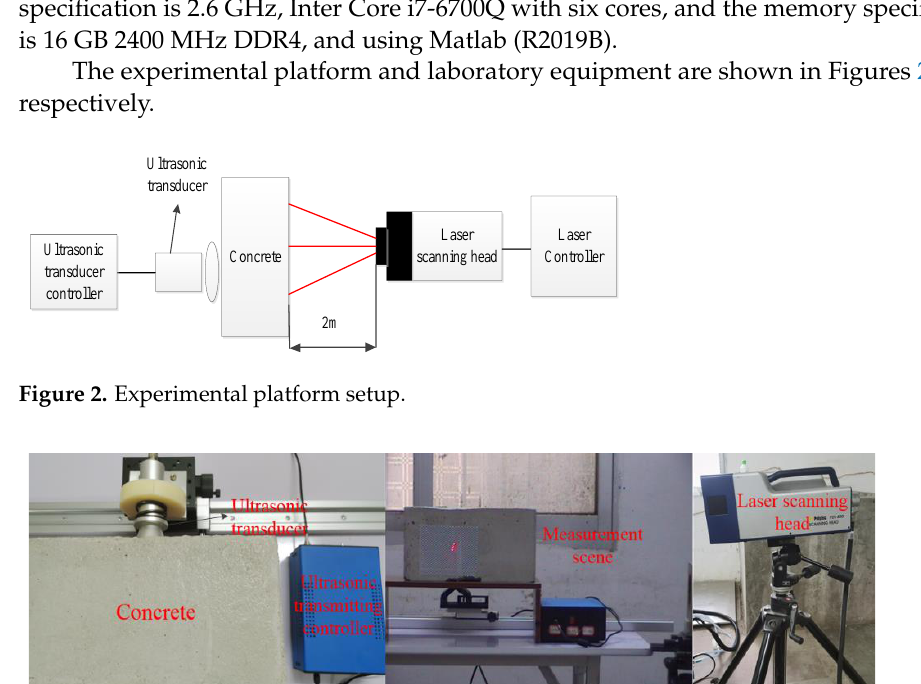
Figure 1. ( a ) Shape and embedded depth of cavity defect; ( b ) Shape and embedded depth of for- eign matter defect.